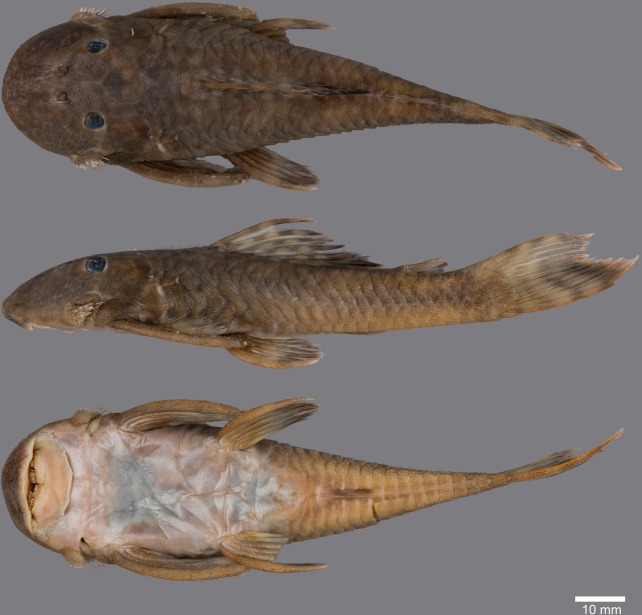
Guyanancistrus teretirostris.MZUSP 117149, holotype, 97.6 mm SL; Brazil: Sipaliwini/Parú Savannah in Trio Amerindian territory at the Suriname-Brazil border, tributary of Parú de Oeste River.